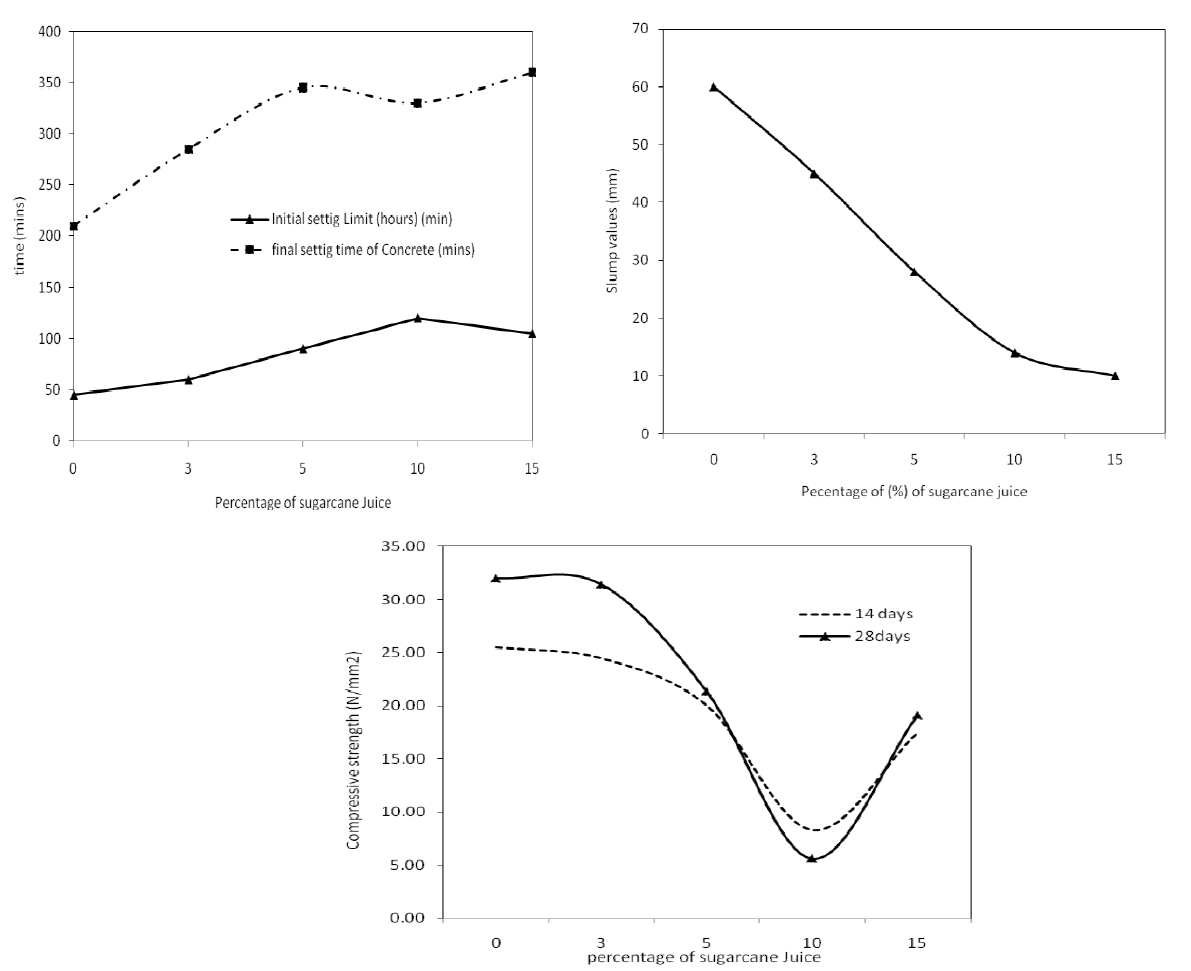
Figure 5. Test results showed molasses (sugar) affecting concrete properties (Pathan and Singh